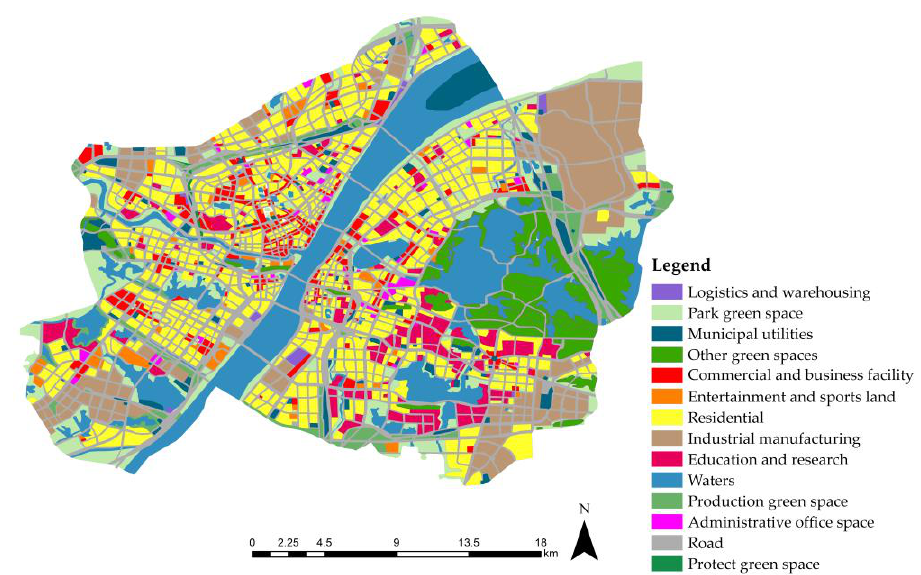
Figure 3. Distribution of land types on vector map.